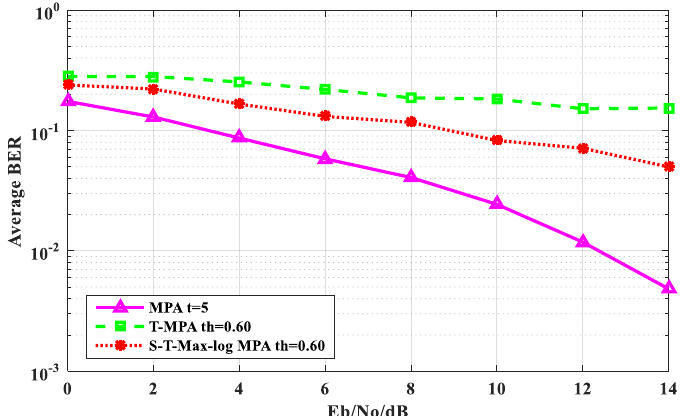
Figure 6. Comparison of average BER performance when t max = 5 and th = 0.60.